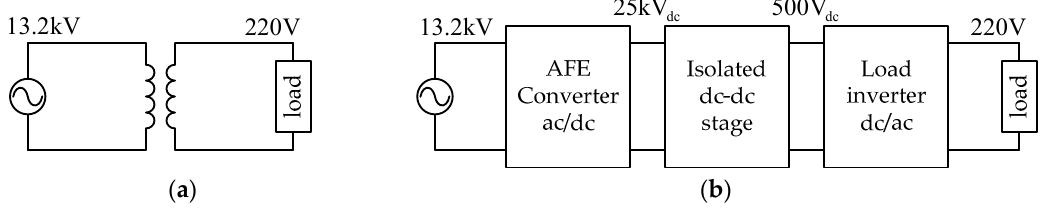
Figure 1. Distribution Transformer ( a ) Traditional distribution transformer ( b ) the solid-state-transformer (SST) configuration. AFE: active-front-end. Table 1. Comparison between a traditional distribution transformer and the solid-state-transformer. Traditional Transformers